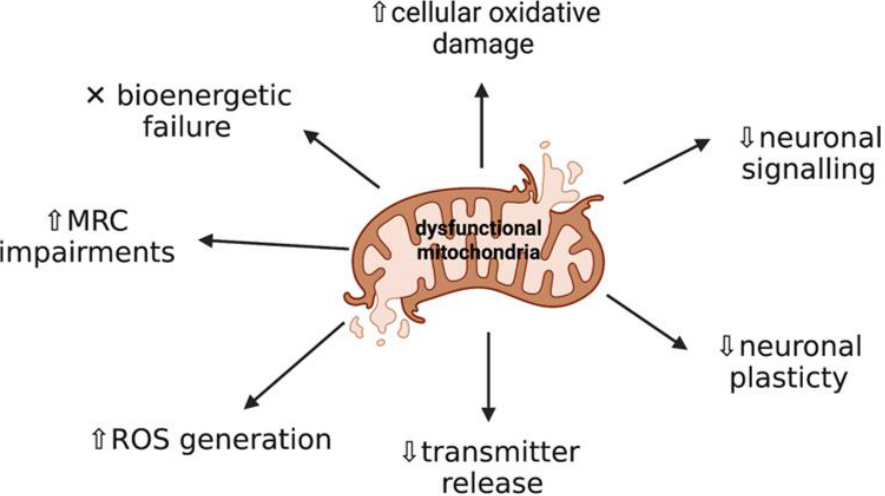
Figure 1. Mitochondrial dysfunction can lead to several deleterious consequences, contributing to the development and progression of neurodegeneration in a range of diseases. Failure to remove dysfunctional mitochondria can have profound effects on the central nervous system, leading to cellular distress and damage, ultimately leading to neuronal death. Up arrows represent increases and down arrows represent reductions (created using biorender.com, accessed on 17 June